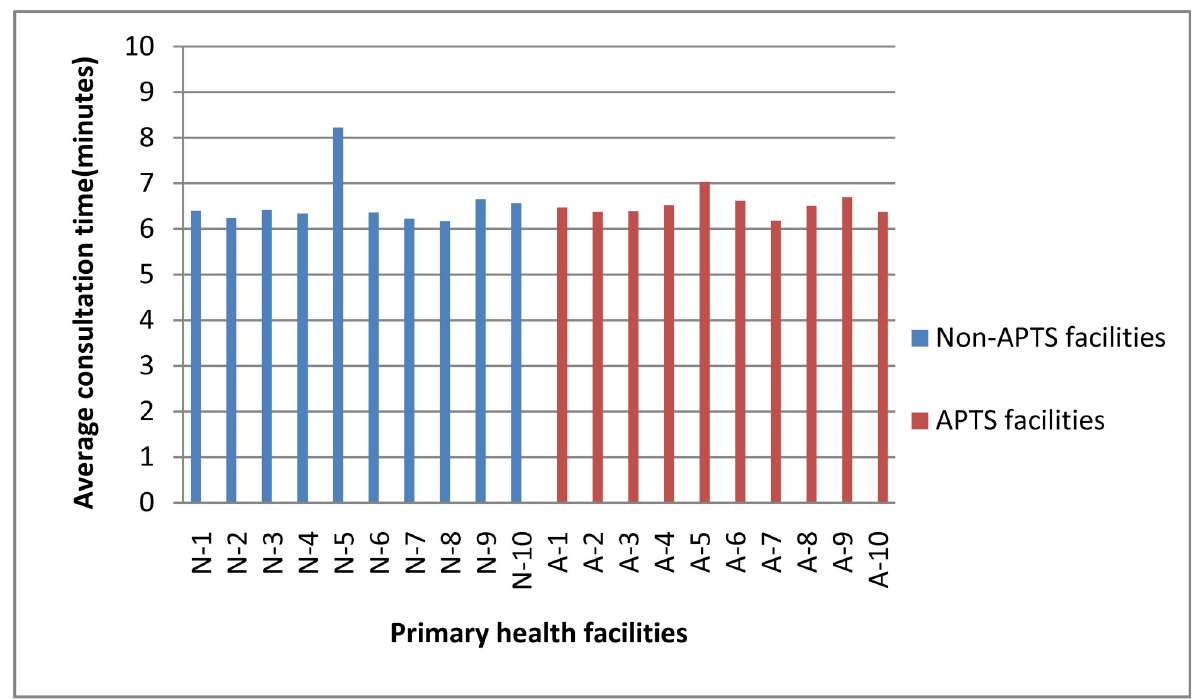
Fig 4. Average consultation time in minutes between individual APTS and non-APTS facilities. N-Non-APTS A-APTS.